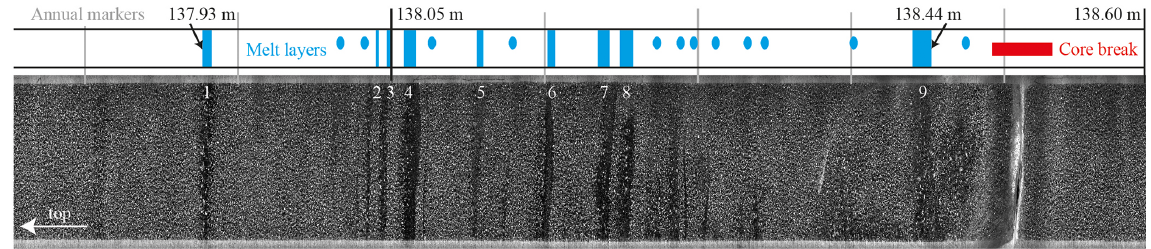
Figure 8. Nine melt layers and 12 melt lenses (blue bars and ellipses, respectively) within just 50cm at around 138m depth. Vertical gray lines represent annual markers. The depth 138.05m corresponds to the year 986CE (GICC05) or 991CE